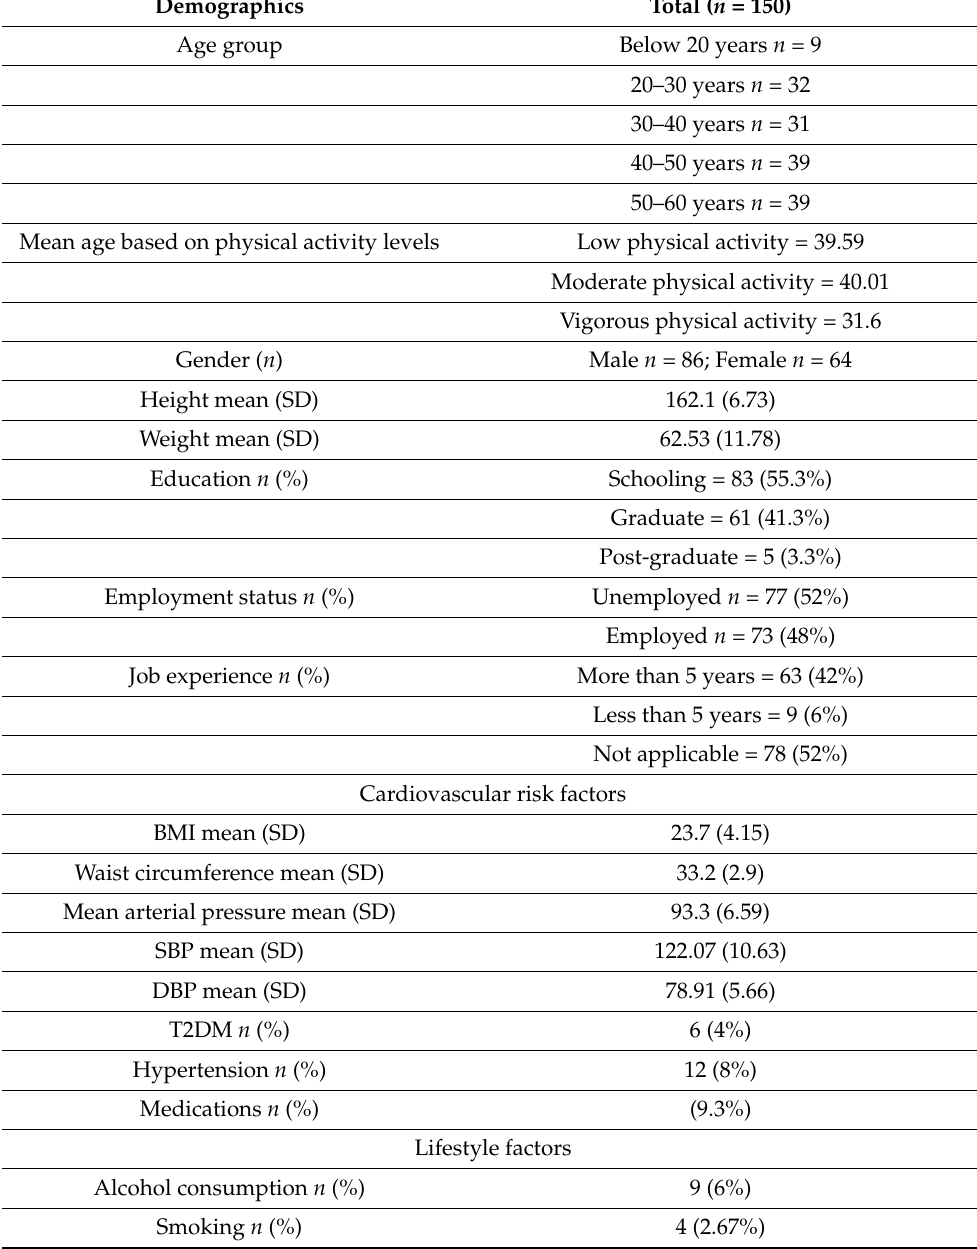
Table 1. Demographic, Cardiovascular risk factors, and Lifestyle factors of the